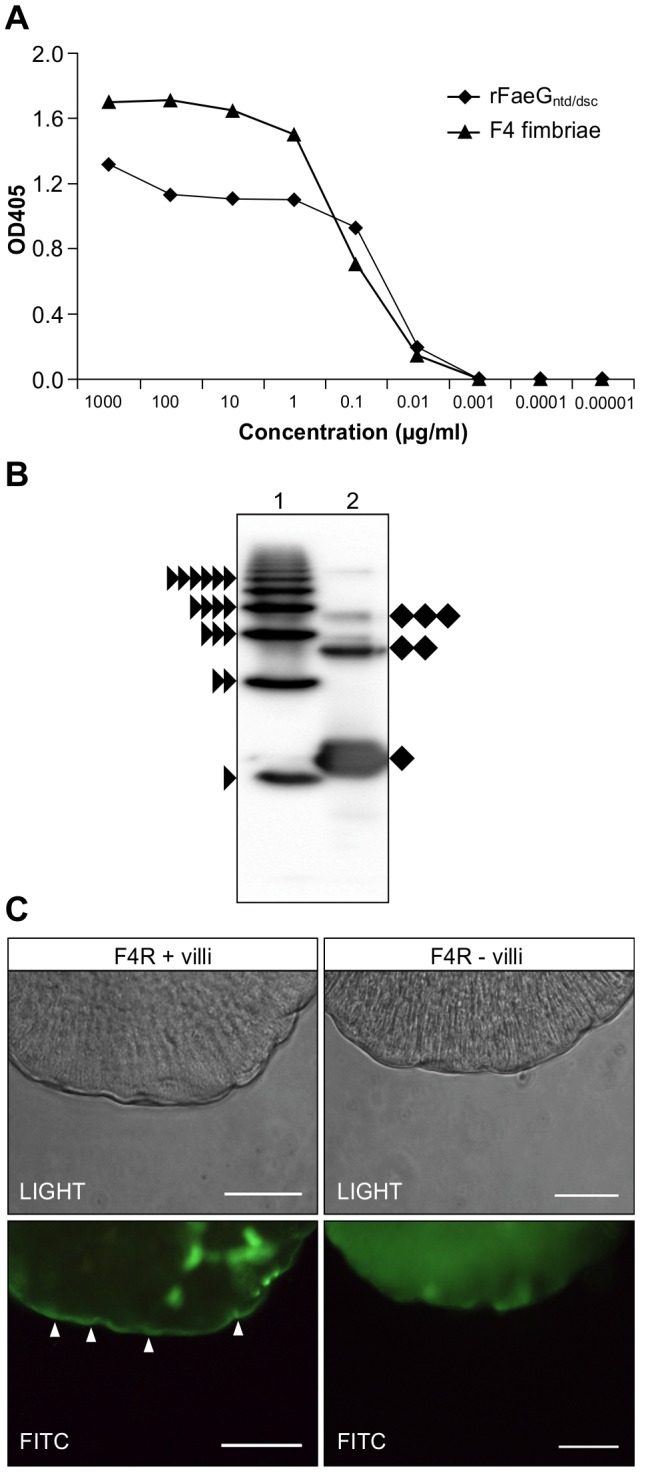
Chloroplast-produced rFaeGntd/dsc protein is recognized in F4 fimbriae-specific ELISA, partially polymerizes and specifically binds to the brush border of F4R+ small intestinal villi.(a) Both rFaeGntd/dsc and F4 fimbriae are recognized by a monoclonal anti-F4ad fimbriae antibody in ELISA. (b) Purified F4 fimbriae (lane 1) and purified rFaeGntd/dsc (lane 2) were resolved under non-reducing conditions to assess polymerization. The F4 fimbriae sample displayed the formation of native FaeG polymers, number of subunits is indicated by stacked black triangles next to each band. Most of the rFaeGntd/dsc is present as monomers (denoted by black rhomb); formation of rFaeGntd/dsc dimers and trimers was also observed (two and three stacked black rhombs). (c) Adhesion of the rFaeGntd/dsc protein to the brush border of F4R+ small intestinal villi. Binding to the F4-specific receptors present on the apical surface of the epithelial cells, which line the brush border of F4R+ small intestinal villi is shown as a bright line on the edge of the sample, the result of excited FITC fluorochrome (indicated with white arrows, lower panel). rFaeGntd/dsc fails to bind to brush border of F4R− small intestinal villi. Images are representative of rFaeGntd/dsc adhesion to isolated villi of three F4R+ and two F4R− piglets. Bar: 50 µm.